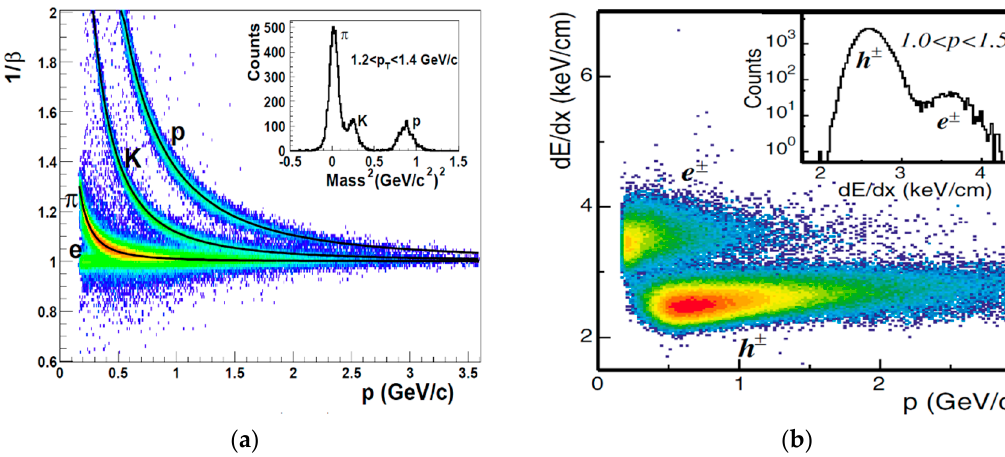
Figure 4. ( a ) 1/ β vs. momentum for π ± , K ± , and p( p) from 200 GeV d+Au collisions. Reproduced with permission from STAR Collaboration, Physics Letters B; published by Elsevier B.V., 2005 [57]. Insert: the distribution of the square of the mass for momentum in the range of 1.2 and 1.4 GeV/c. ( b ) dE/dx in the TPC vs. particle momentum ( p ) with a ToF cut of | 1/ β − 1 | ≤ 0.03. The figure is mapped low statistics bin to blue and high statistics bin to red. Reproduced with permission from Adams et al., Phys. Rev. Lett.; published by the American Physical Society, 2005 [59]. Insert: projection on the dE/dx axis for particle momenta 1 < p < 1.5 GeV/c.